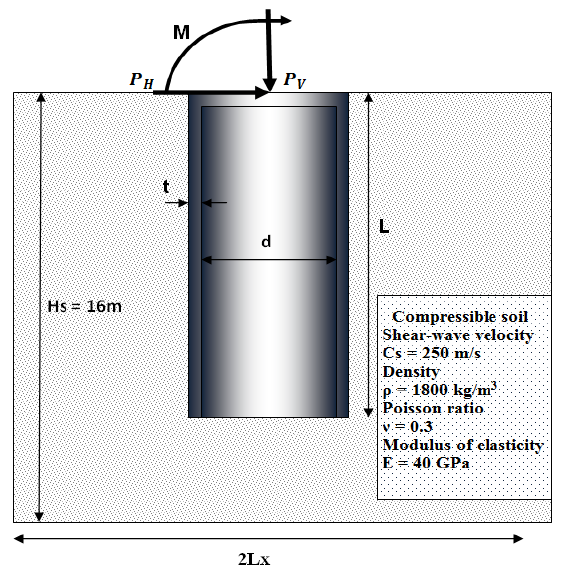
Figure 4: Geometry of the numerical model. Vertical and horizontal dynamic response of suction caisson foundations